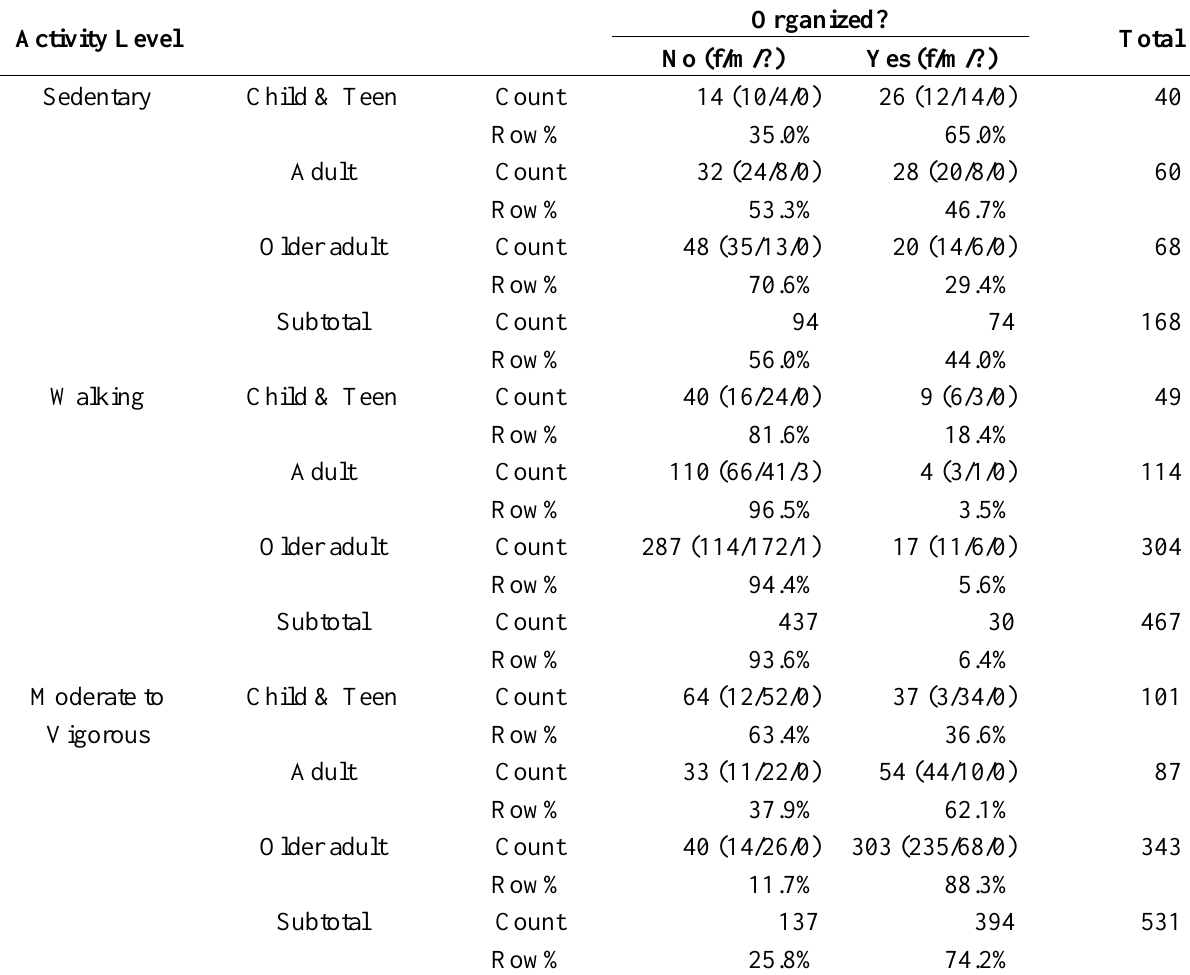
Table 6. Physical activity level by organization level and age